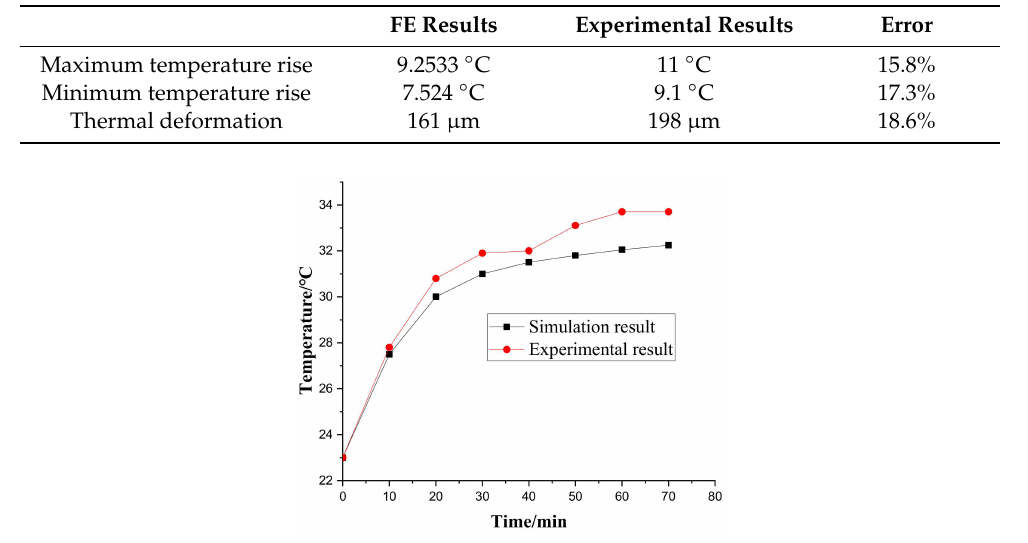
Figure 10. Temperature rise of Node A.